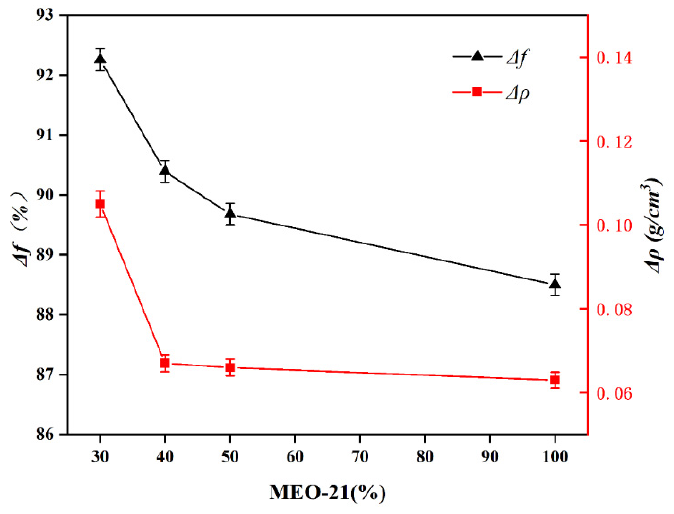
Figure 11. MEO-21 different proportions of test results.